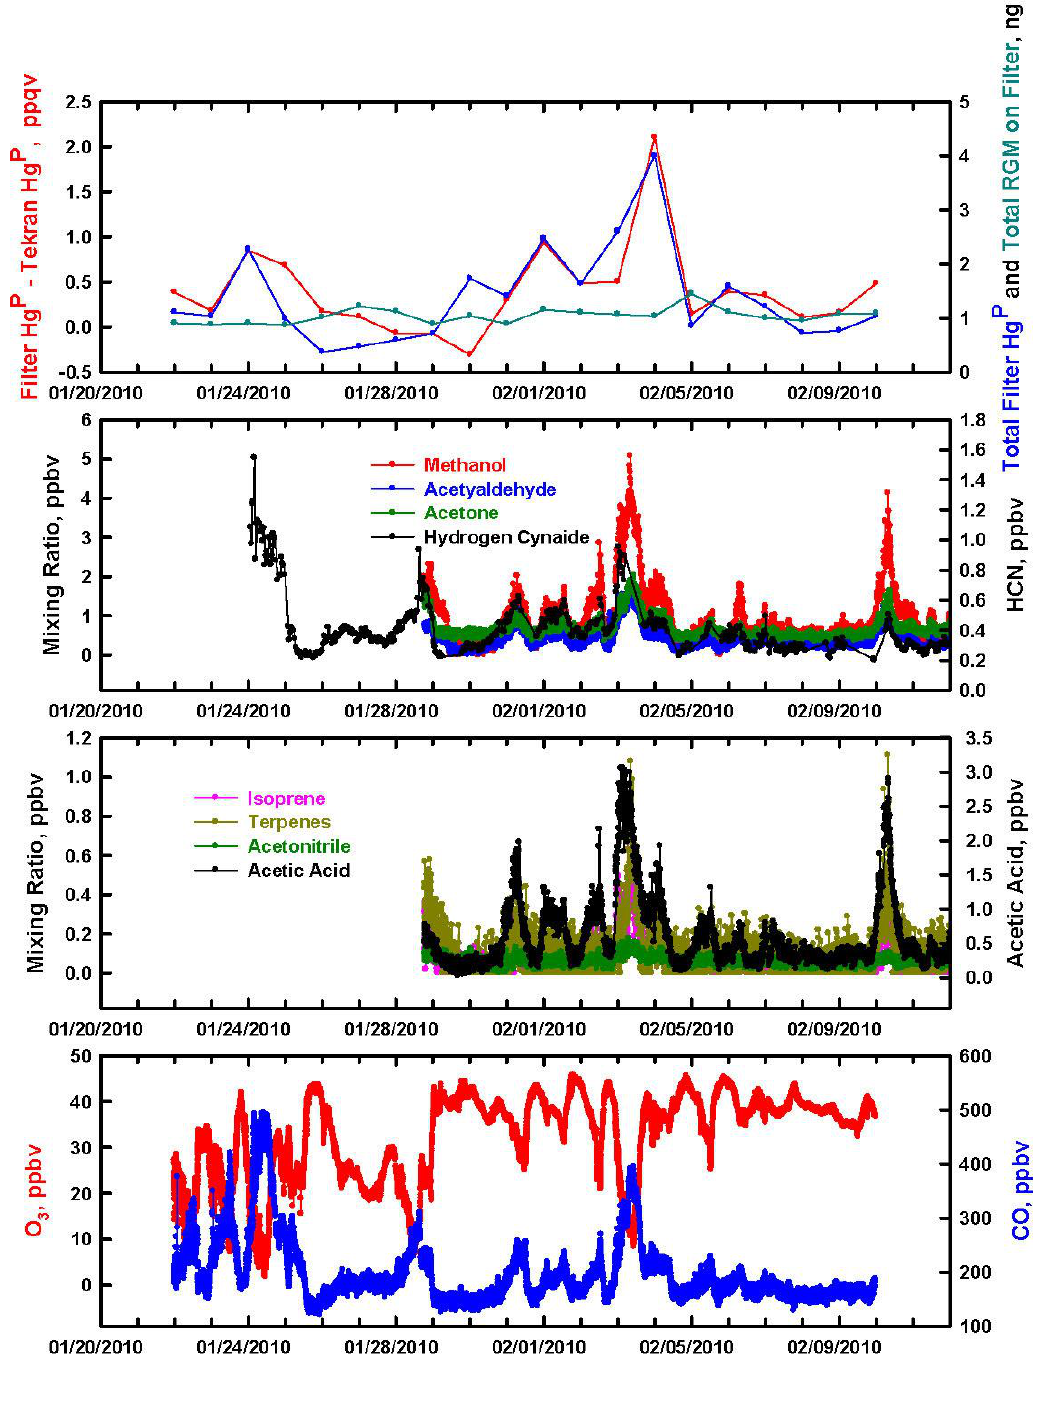
Figure 7. Top panel—Comparison of total Hg from potential collection of all RGM on filter during the spring sampling interval at Thompson Farm. Middle panels—Time series of selected hydrocarbon/halocarbons/oxygenates/HCN. Bottom panel—Time series of O and